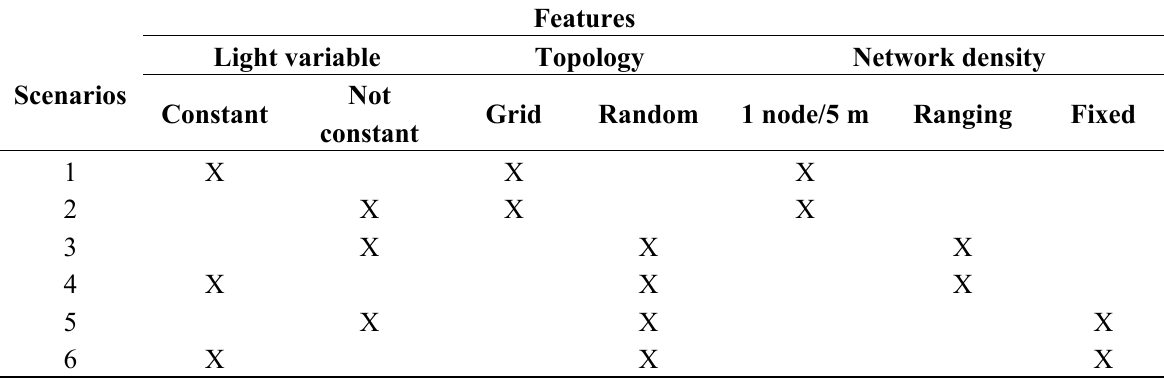
Table 2. Characteristics of the simulation